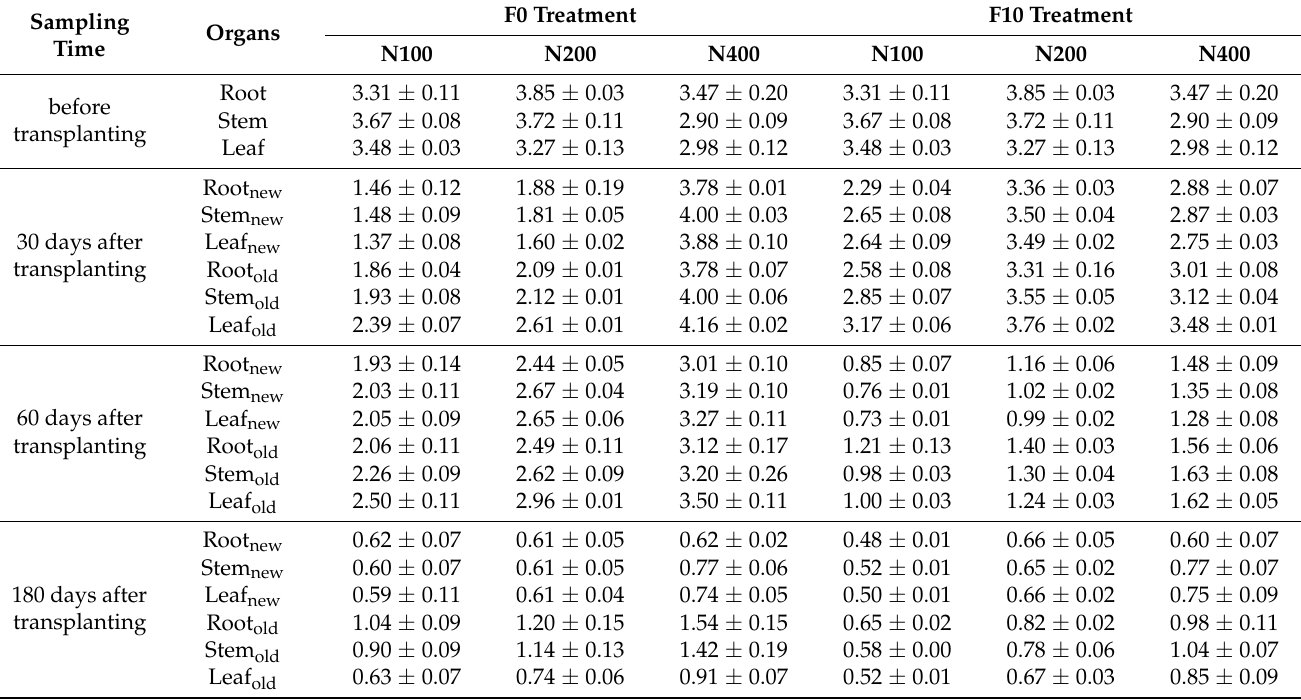
Table A1. Atom % of 15 N in different organs of Betula alnoides plants at four sampling